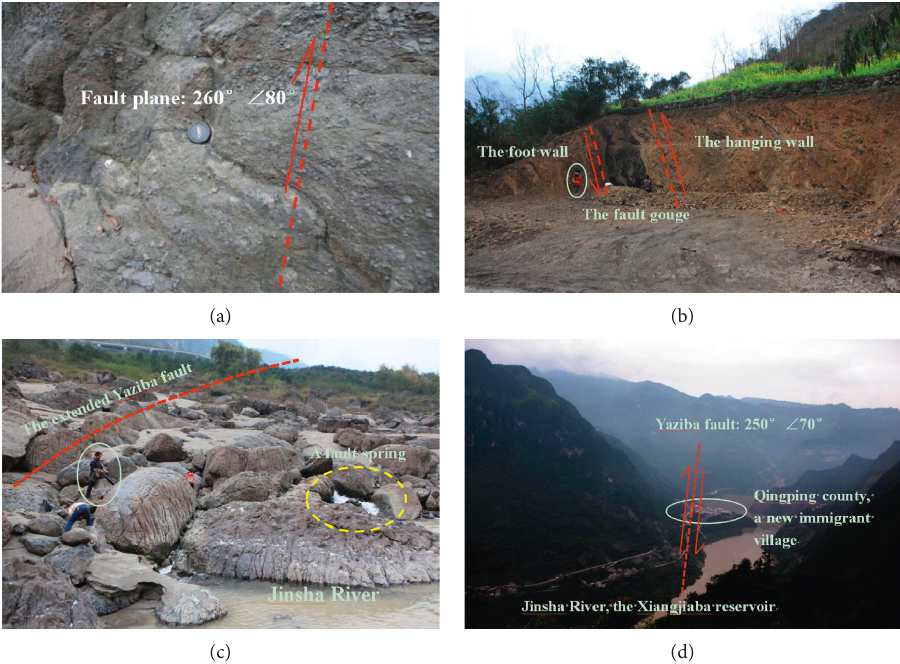
Figure 5: Some evidence for the newly discovered part of the Yaziba Fault. (a) The fault breccia on the right bank of the Jinsha River, (b) the fault gouge on the left bank of the Jinsha River, (c) a spring on the fault zone, and (d) the Jinsha River valley that the Yaziba Fault passes through. See Figure 4 for locations.